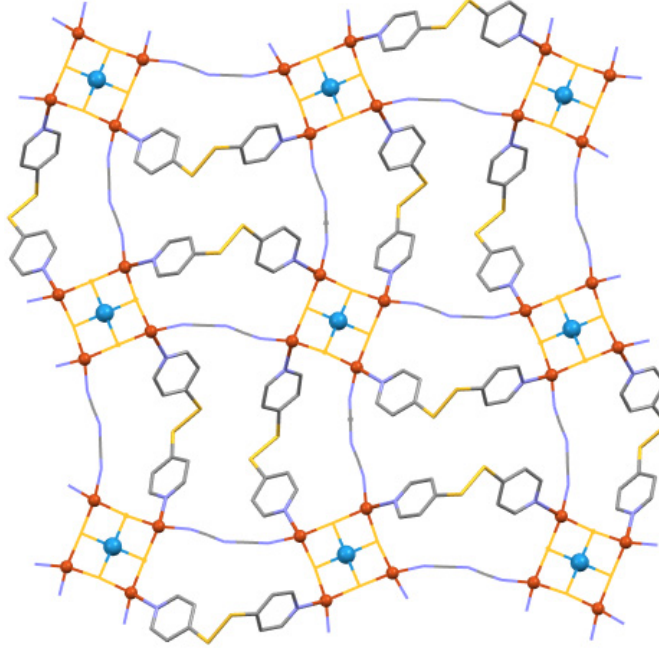
Figure 28. Coordination network in [WS viewed along the a axis